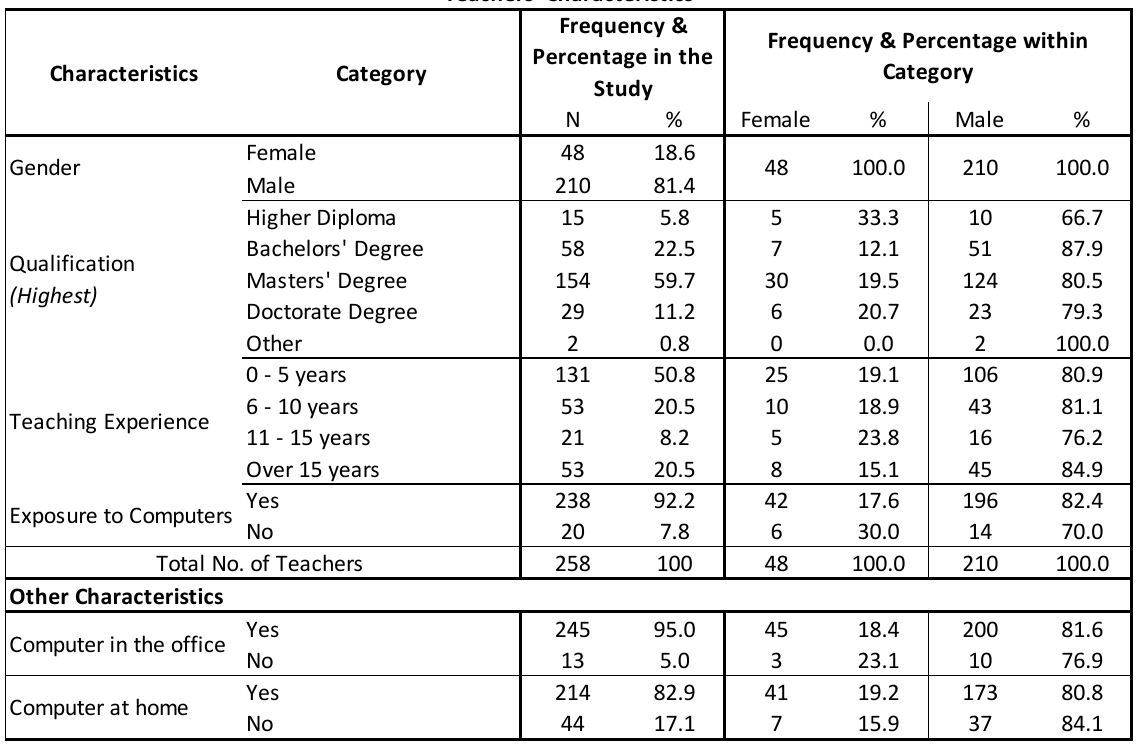
Basic Characteristics of